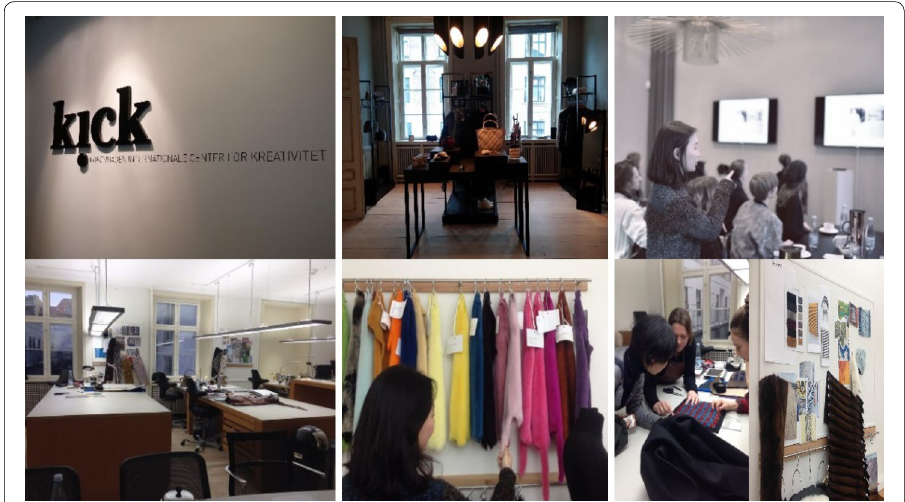
Fig. 7 Introduction and sharing of design development and working process at KiCK, photographed by the author except for 3rd picture in the upper line from WFUR